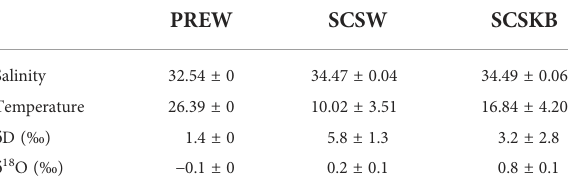
TABLE 1 The isotopic characteristics of the PREW, SCSW, and SCSKB in the PRE and the adjacent northern